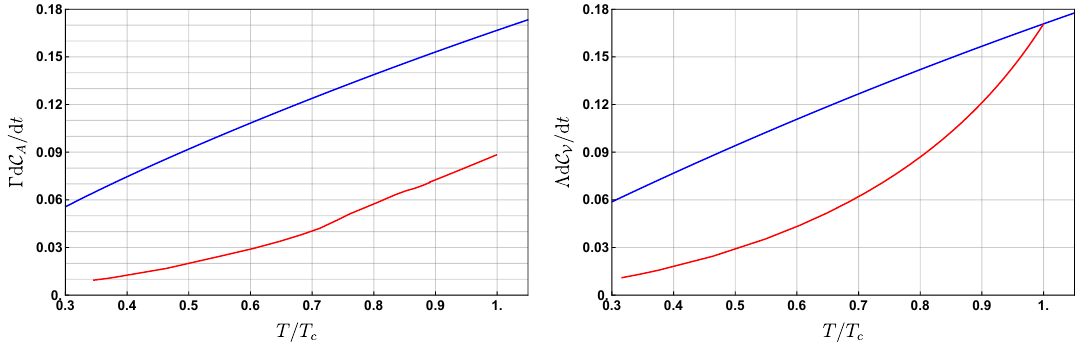
Figure 16 . The late-time complexity growth rate for the CA duality (left) and the CV duality (right) as a function of temperature. The blue lines correspond to the behavior for the normal phase, while the red lines correspond to the superconducting phase. There is a sharp discontinuity at T for the CA case. We choose Γ = 16 π 2 G